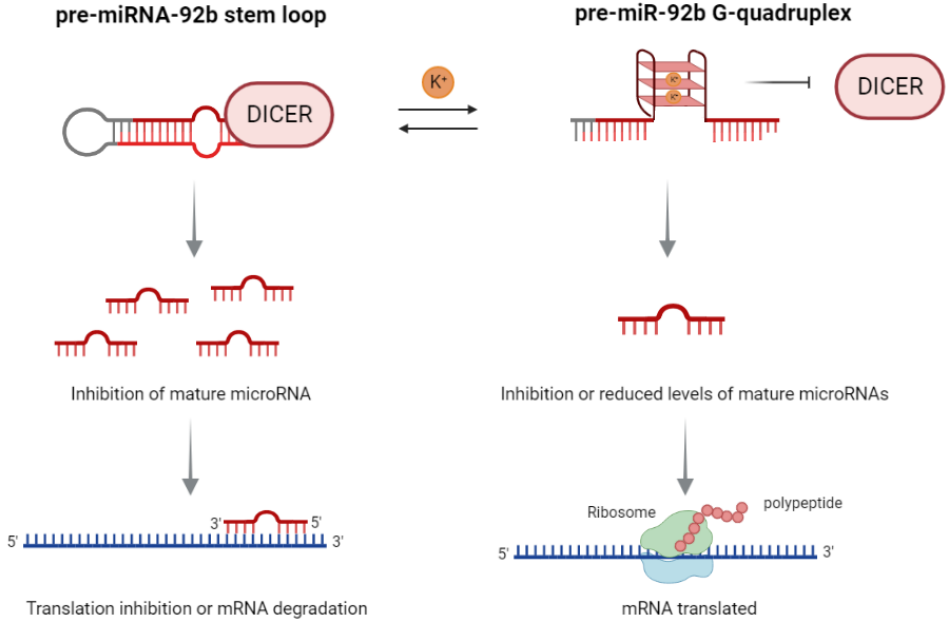
Figure 6. Representation of the ionic profiling to induce G4 formation by unwinding the stem − loop of pre-miR-92b Adapted from [44] copyright (2015), with permission from Elsevier.